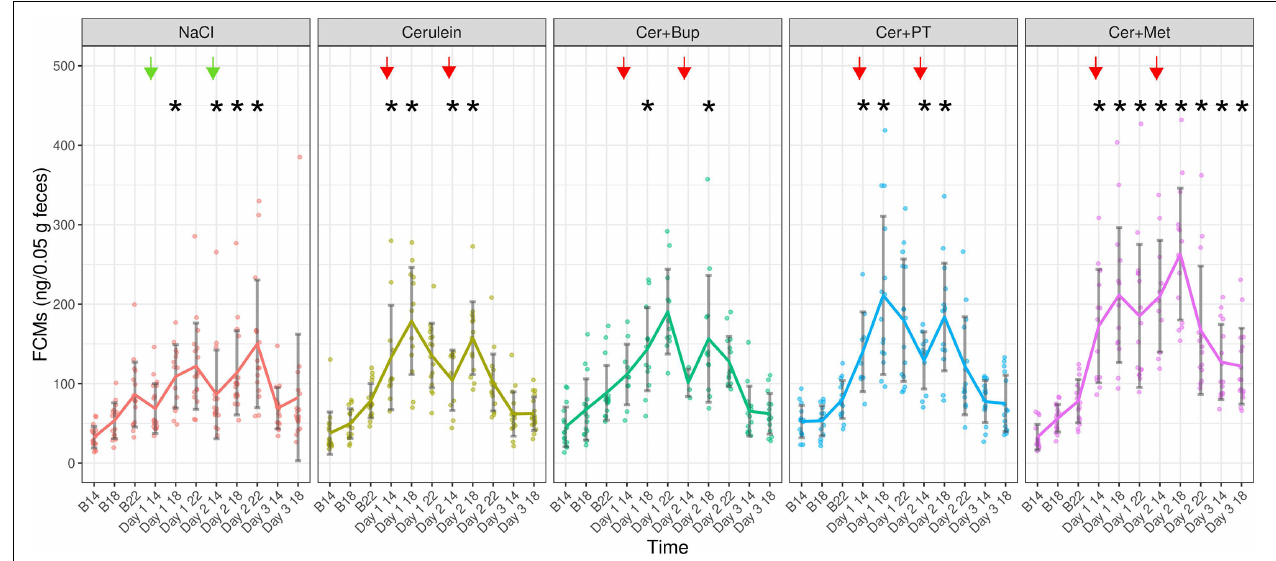
FIGURE 7 | Fecal Corticosterone Metabolites (ng/0.05 g feces) were measured at the respective baseline time points (B14/18/22), and 1, 5, and 9 h after the last injection of the day, as well as at 26 and 30 h after the last overall injection. Each dot indicates the FCM concentration of one fecal sample, which can be lower than the actual animal number as feces could not be obtained from all animals. Bonferroni post hoc detected that on Day 1 at 14:00 and 18:00, NaCl showed significantly lower FCMs than Cer, Cer + PT, and Cer + Met while Cer + Met showed significantly higher FCMs than Cer + Bup. On Day 1 at 18:00, Cer + PT had significantly higher FCMs than Cer + Bup. On Day 1 at 22:00, significantly lower FCMs were detected in NaCl compared with the three groups with Cerulein and analgesia. On Day 2 at 14:00 and 18:00, Cer + Met treated animals showed significantly higher FCMs than the other groups and Cer + PT had significantly higher FCMs than NaCl. On Day 2 at 22:00, Cer + Met had higher FCMs than Cer. On Day 3, Cer + Met showed significantly higher FCM levels than NaCl, Cer, and Cer + Bup at 14:00. At 18:00 Cer + Met had higher FCMs than Cer and Cer + Bup. *Significant ( p ≤ 0.05) differences from the respective baseline measurements. Data are shown as scatter dot plot with mean ± SD. NaCl n = 18, Cer n = 17, Cer + Bup n = 16, Cer + PT n = 15, Cer + Met n =